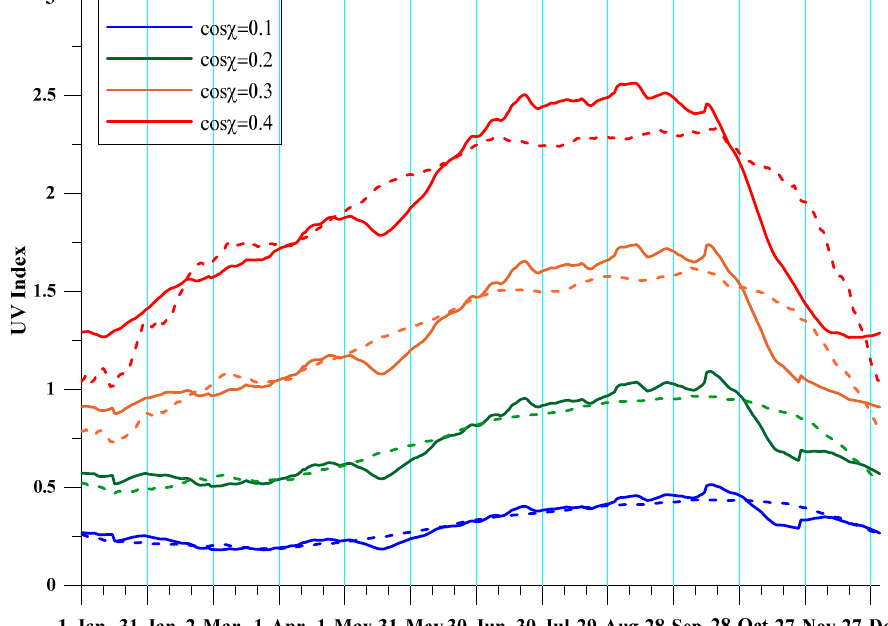
Figure 9. Seasonal distribution of UV-Index estimates at fixed zenith angles of the Sun (all solid lines) and values obtained by linear regression with Total Ozone Column and the concentration of PM10 (all dash lines).